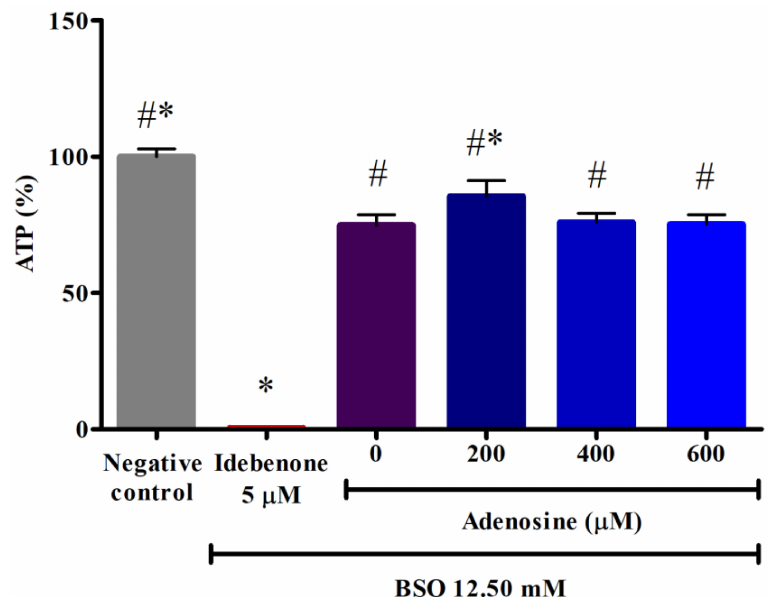
Figure 4. Effects of adenosine on the ATP level in FRDA fibroblasts treated with BSO. The ATP level was evaluated following pre-treatment with adenosine for 2 h and 12.50 mM BSO for 24 h. Data are expressed as mean ± SD and statistically analyzed by one-way ANOVA with Tukey’s post-hoc test. Hash (#) and asterisk (*) indicate significant differences ( p < 0.05) in ATP level compared to the idebenone group and BSO-treated (0 µ M adenosine) group, respectively. ATP, adenosine triphosphate; BSO, L-buthionine